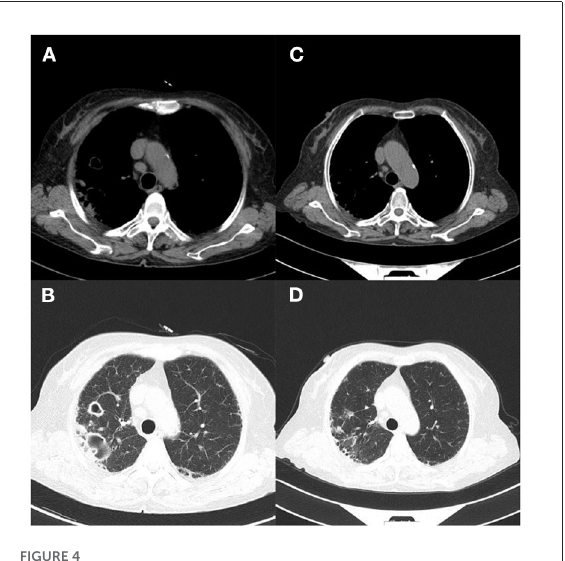
FIGURE2 Case 1. (A,B) Chest CT 1 month after hospitalization showed improved pulmonary inflammation and reduced lesions; (C,D) Chest CT reexamination 38 days after admission showed more absorption of lesions, and significantly improved lung inflammation.